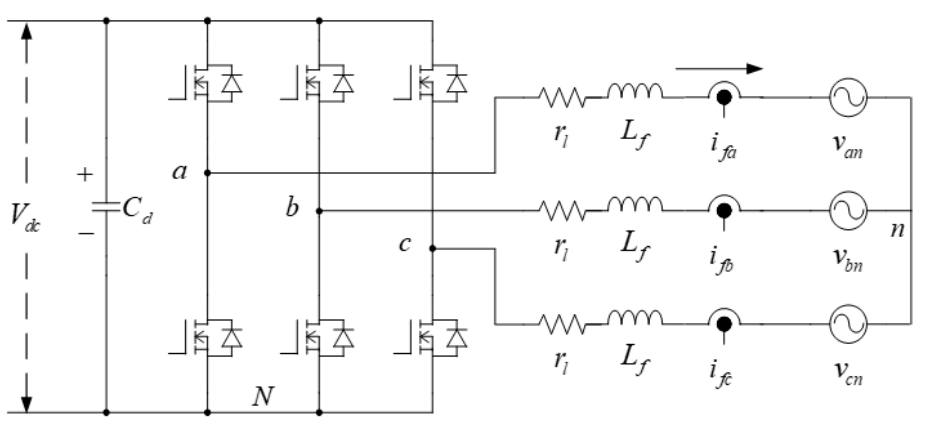
Figure 4. Schematic architecture of the proposed LVRTC on a three-phase grid-connected inverter.